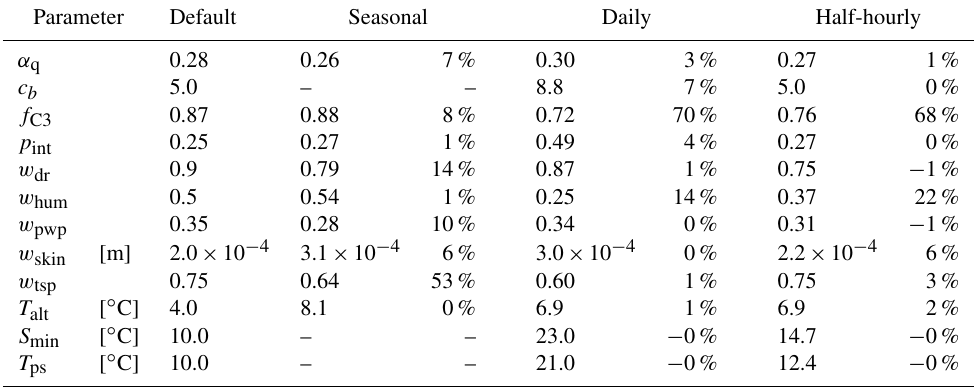
Table 4. Default and optimised parameter values using the last 20000 samples (if no value is given, the parameter was not part of that tuning, and the default value was used instead). The percentage next to a parameter value is the effectiveness of that parameter for that tuning. The reference values for seasonal tuning are the default values and for daily and half-hourly tunings the seasonal values. Parameter Default Seasonal